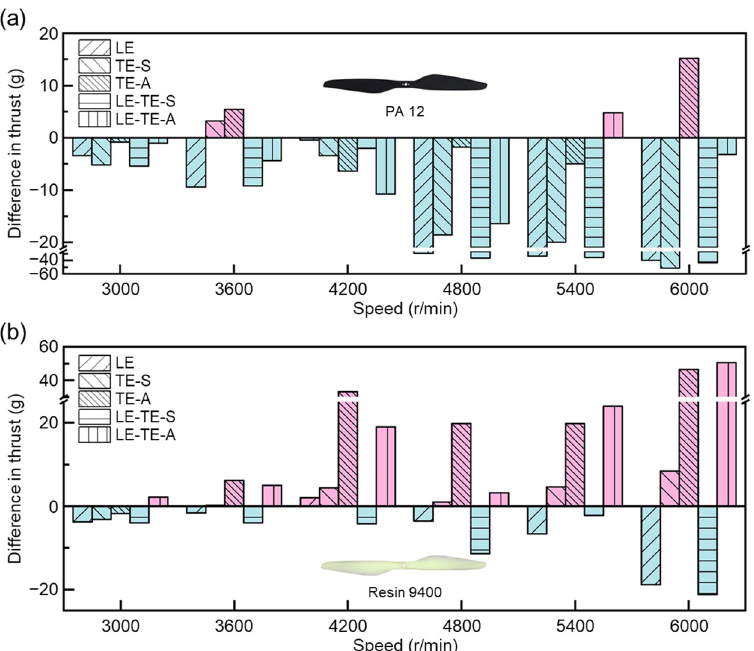
Figure 9. Comparison of thrust with different rotors. ( a ) Bionic rotors with PA 12; ( b ) Bionic rotors with Resin 9400. The thrust of the OR rotor was taken as a reference value (0 g). Under the same conditions, the increase in thrust was positive and the decrease in thrust was negative.